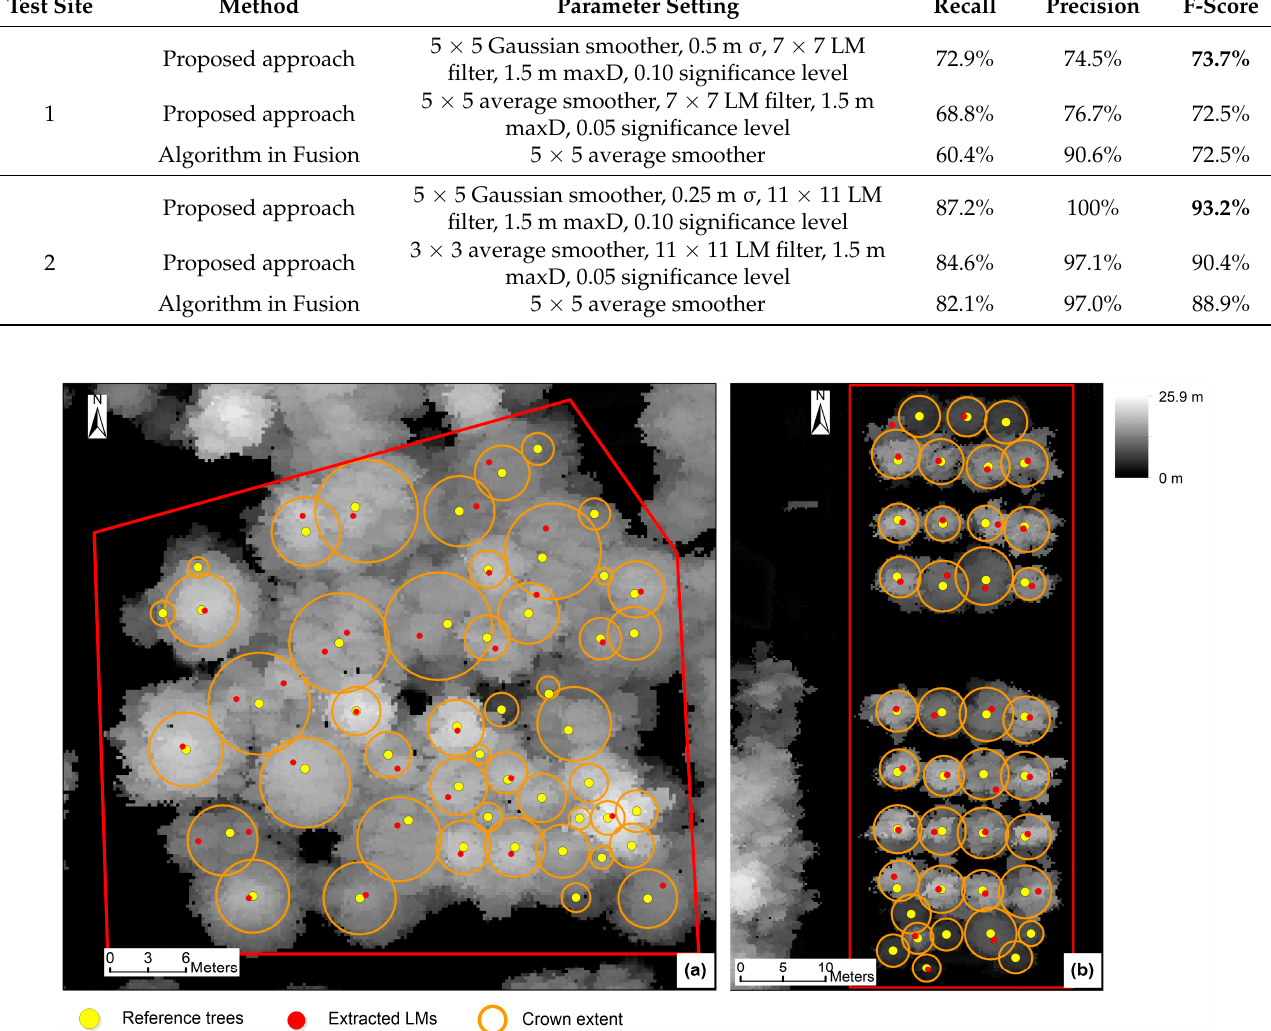
Figure 19. Tree detection results on test sites 1 and 2 using the algorithm in Fusion software: ( a ) Test site 1; ( b ) Test site 2. The CHM resolution is 0.25 m. The parameter values applied in the algorithm can be found in Table 4. Table 4. Individual tree detection results derived by using the proposed approach and the algorithm in Fusion software. Test Site